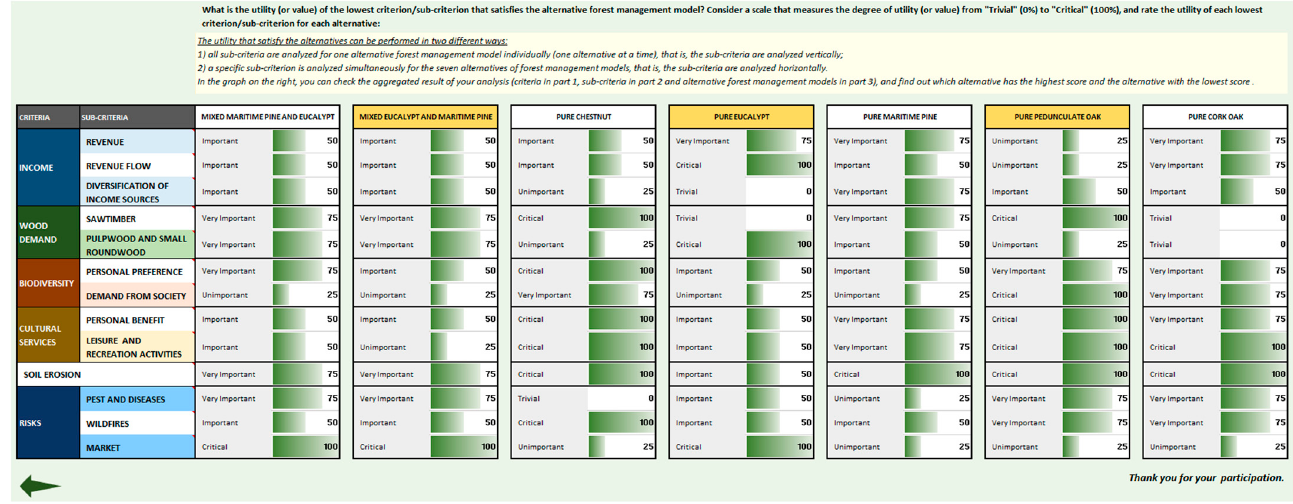
Figure 6. Multicriteria questionnaire to evaluate and rate the utility of the attributes of alternatives (columns) with respect to the lowest-level criteria or sub-criteria (rows).